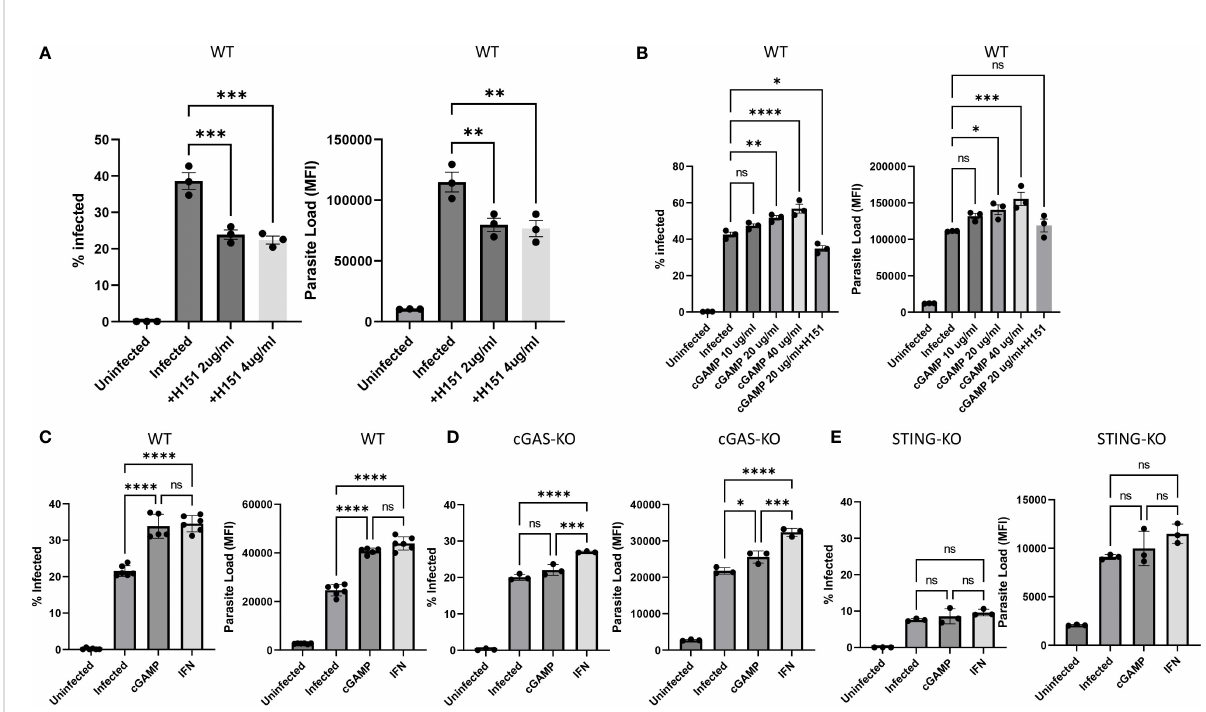
FIGURE 3 Effect of the STING agonist 2 ’ 3 ’ -cGAMP, the STING antagonist H151 and recombinant IFN- b on in vitro Leishmania infection. Differentiated WT [ (A) , (B) and (C) ], cGAS- [ (D) ] or STING- (E) knockout THP-1 cells were infected with eGFP expressing L. major parasites at a MOI of 1:10 (macrophage:parasite). Infection percentages and parasite loads were quanti fi ed using a fl ow cytometer 24 h later. H151 [2 or 4 µg/ml; (A) and (B) ], cGAMP [10, 20 or 40 µg/ml; (B) , (C) , (D) and (E) ] or recIFN- b [50 ng/ml; (C) , (D) and (E) ] were added 8, 2 and 8 hours prior to infection, respectively. Data represent average ± SD. All groups were compared statistically by one-way ANOVA followed by Dunnet`s multiple comparison test. ns, not signi fi cant, *p ≤ 0.05, **p ≤ 0.01, ***p ≤ 0.001, ****p ≤